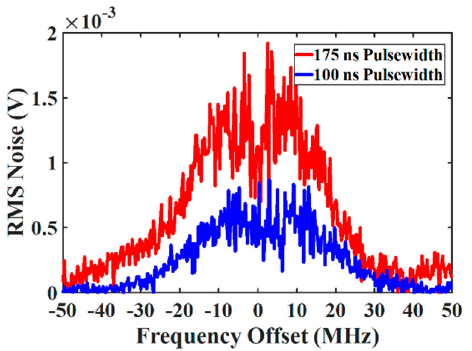
Figure 8. Experimental SBS-induced noise measurement in G-BOTDA for 10- and 17.5-m spatial resolutions.